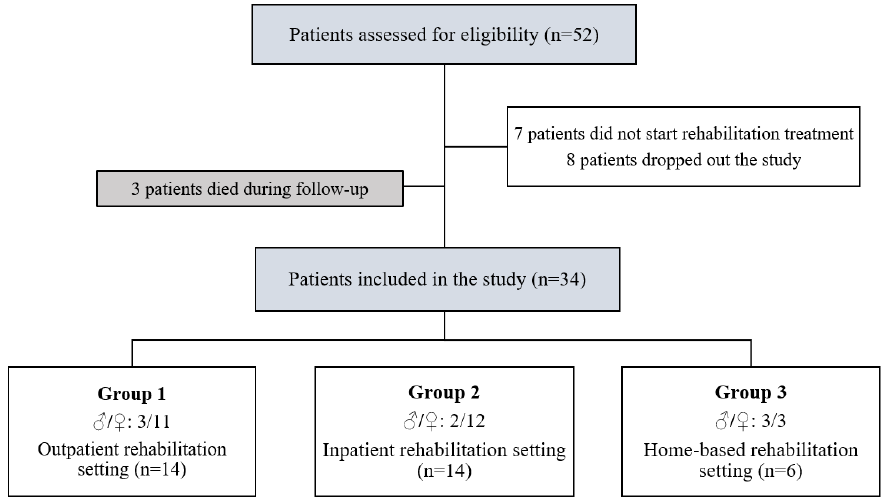
Figure 1. Study flow chart.